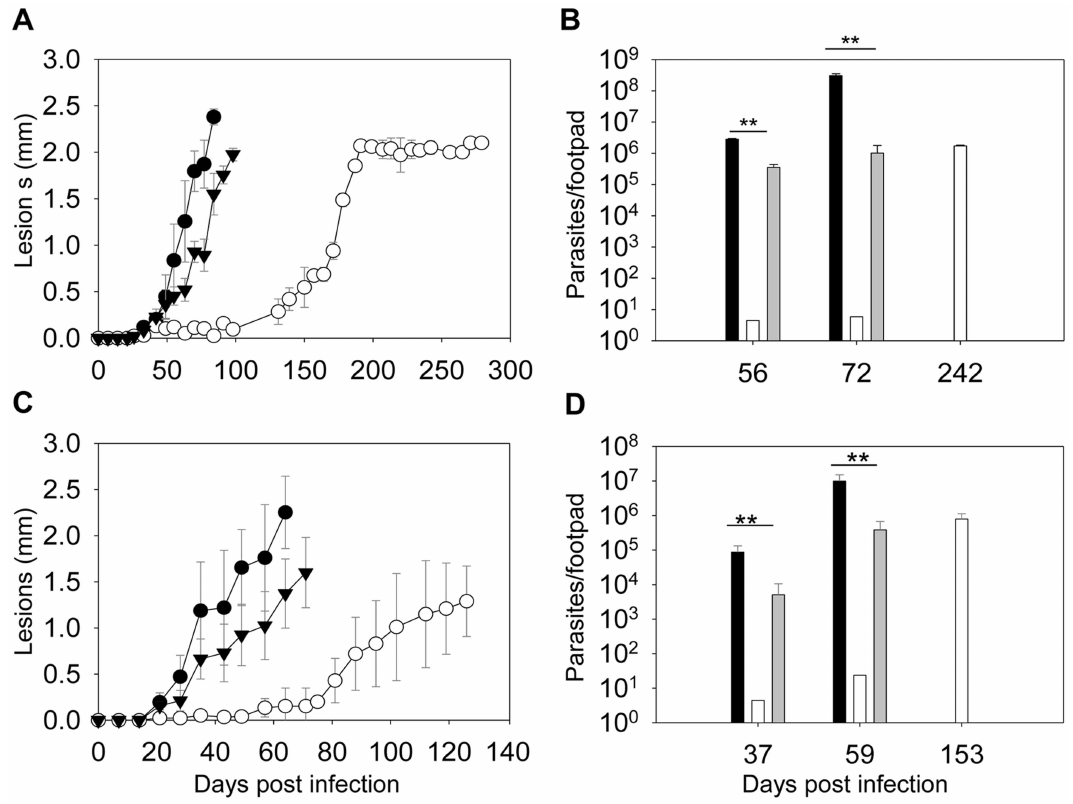
Figure 8. C14dm 2 mutants show severely attenuated virulence in BALB/c mice. BALB/c mice were infected with metacyclics (2 6 10 5 parasites/mouse) ( A–B ) or lesion-derived amastigotes (2 6 10 4 parasites/mouse) ( C–D ). Footpad lesions were recorded weekly and shown in A and C (black circle: WT; white circle: c14dm 2 ; black triangle: c14dm 2 / + C14DM ). Parasite numbers in the infected footpads were determined at the indicated times by limiting dilution assay and summarized in B and D (black bars: WT, white bars: c14dm 2 , grey bars: c14dm 2 / + C14DM ). Error bars represent standard deviations from 5 mice in each group (**: p , 0.01). (Fig. S19A, Table S1 and S2). Similar to c14dm 2 , these ITZ- treated parasites were extremely vulnerable to heat (Fig. S19B).